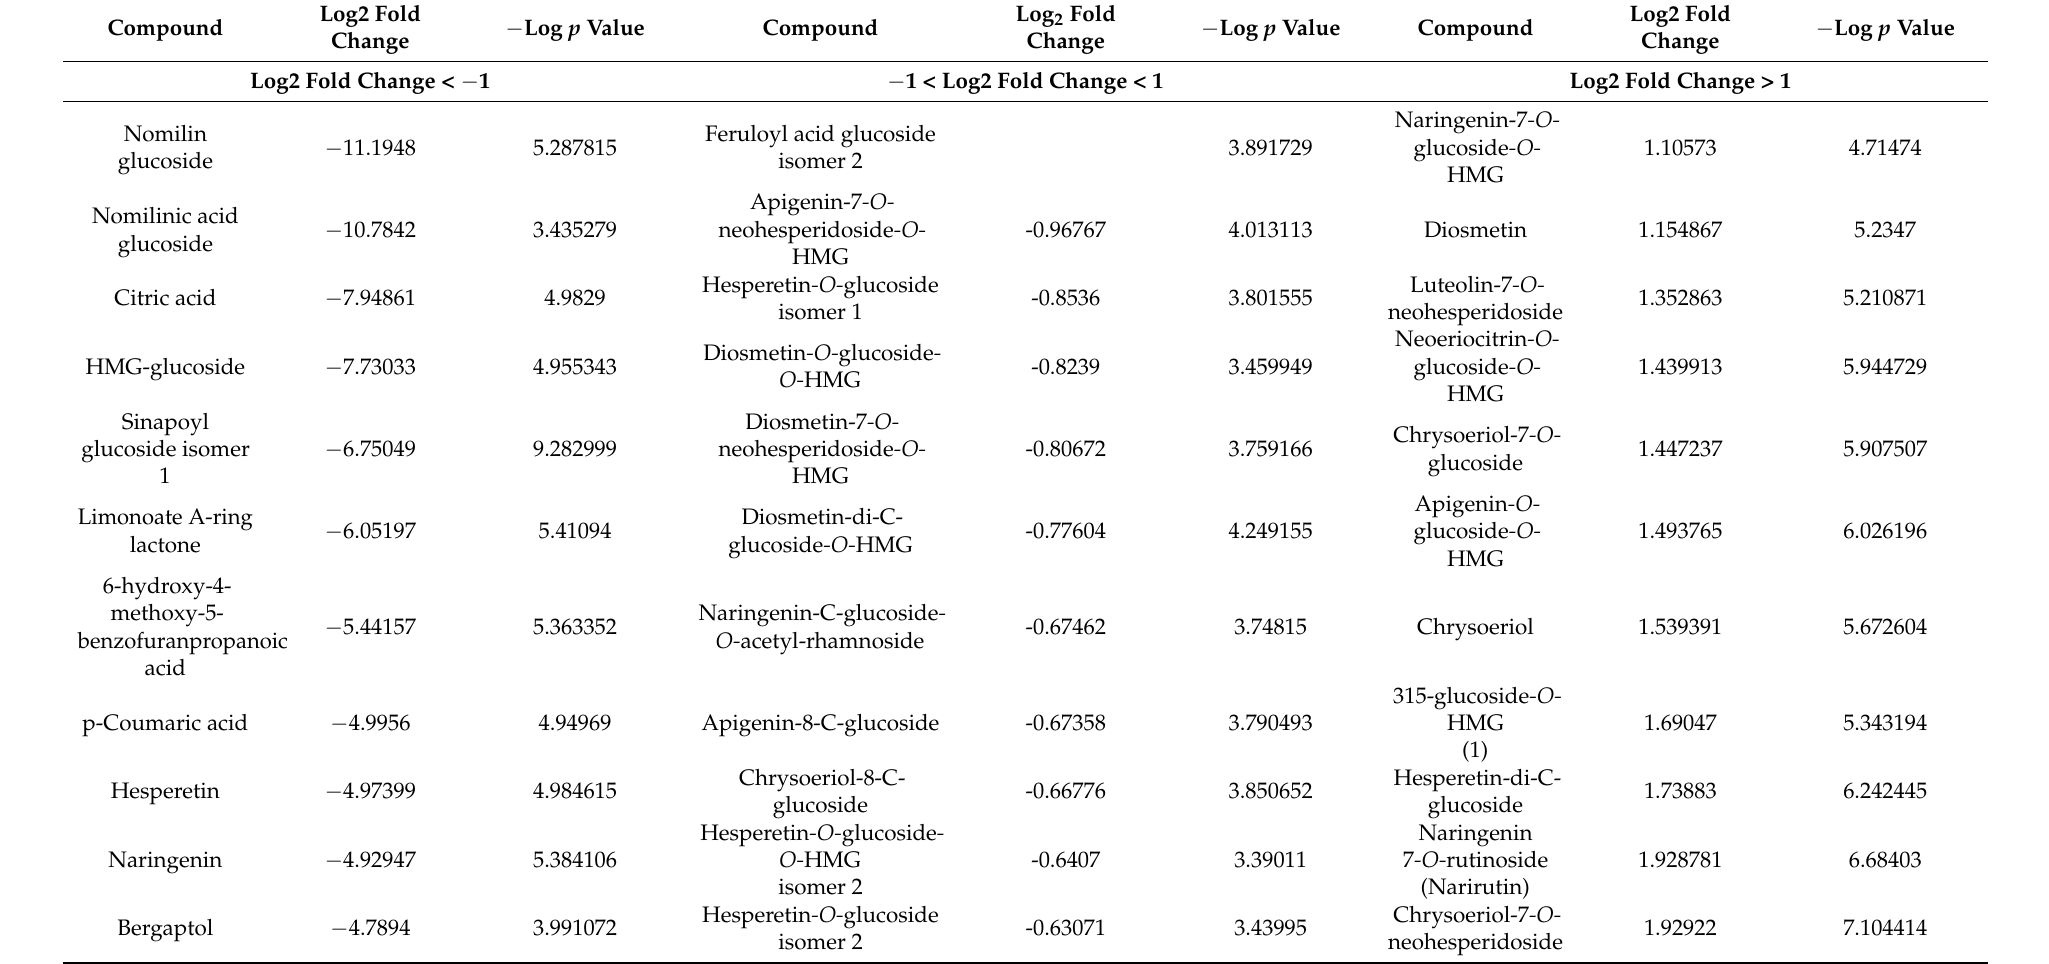
Table 4. Log2 Fold change and − Log p values for the 100 common compounds of the two